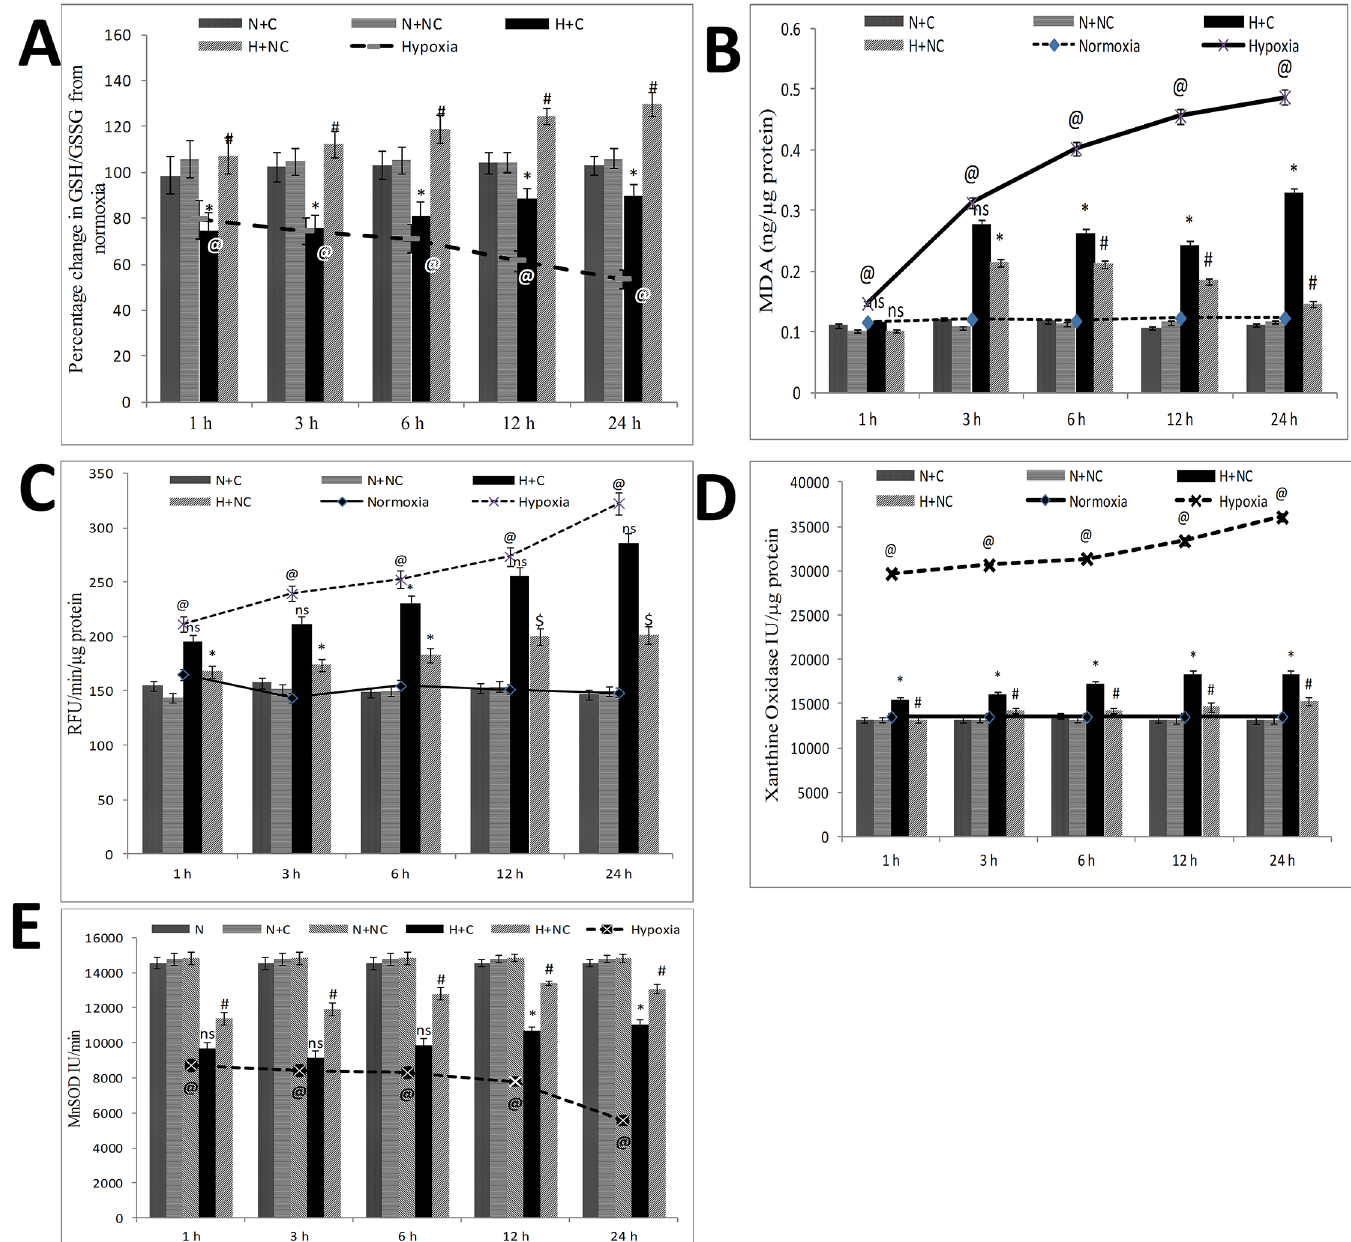
Fig 10. Nanocurcumin protects HVCM cells by restoring oxidative balance: Hypoxia stress disturbed cellular redox balance as depicted by increase in ROS leakage and lipid peroxidation and concomitant decrease in GSH/GSSG content, xanthine oxidase activity and MnSOD activity. Nanocurcumin treatment showed significant improvement in redox status when compared to curcumin treated cells under hypoxia and cells exposed to hypoxia only. No significant change in redox status was observed in cells treated with curcumin or nanocurcumin under normoxia. Values are mean ± SD, significant values represented as @ p (cid:1) 0.05 vs normoxia, # p (cid:1) 0.01 vs hypoxia, * p (cid:1) 0.05 vs